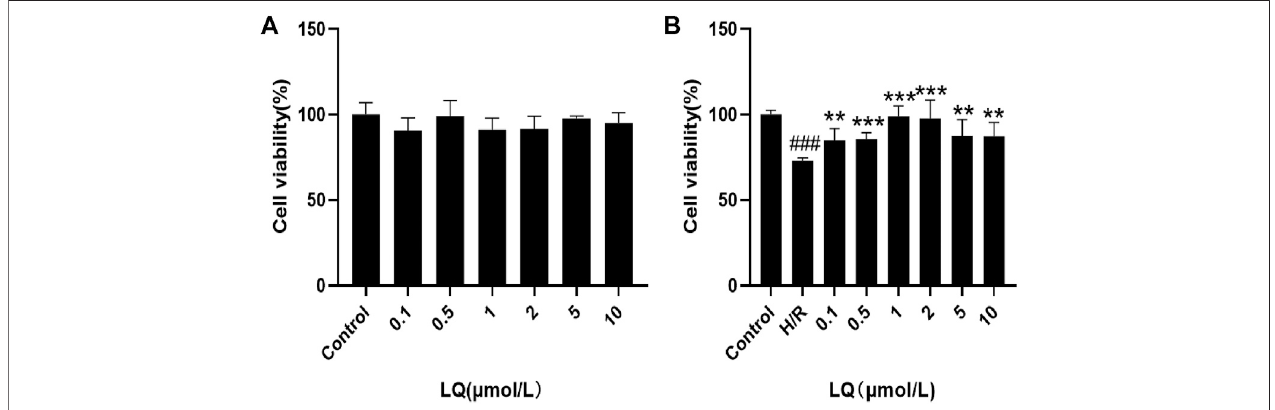
FIGURE 1 | LQ increase cell vitality. (A) LQ under the concentrations of 0.1 – 10 μ mol/L had no effect on HBMECs. (B) The ability of H/R-HBMECs could be increasedundervariousconcentrationsofLQ(0.1,0.5,1 μ mol/L).Everyexperimentwasperformedlessthanthreetimes. ### p < 0.001,comparedtocontrol.** p < 0.01, *** p < 0.001, compared to